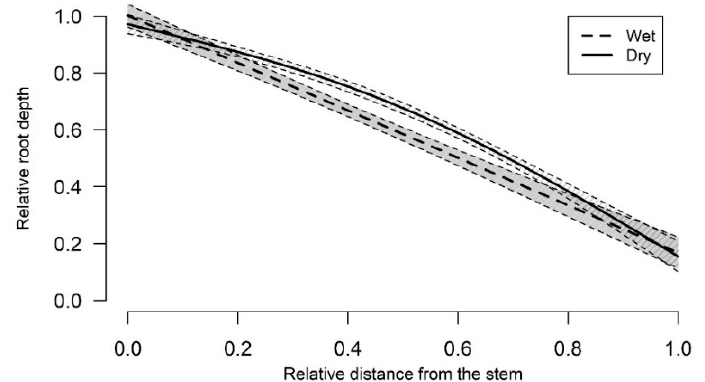
Figure 2. Relative root-soil plate depth distribution at a relative distance from the stem on wet and dry mineral soils. The grey area denotes 95% confidence interval.